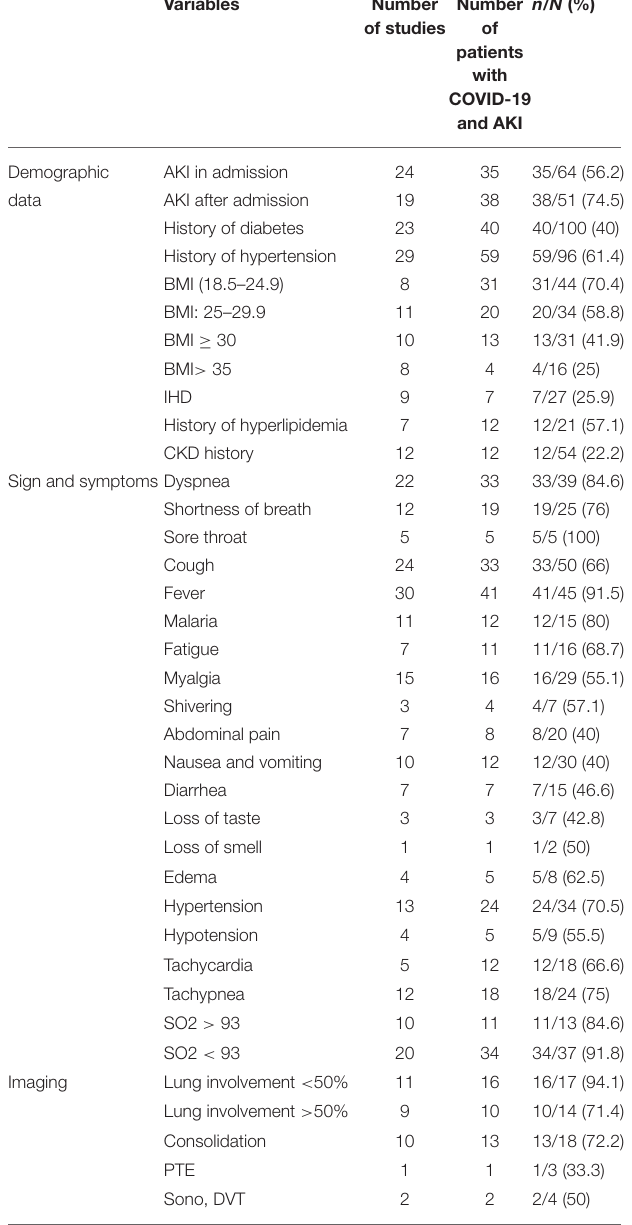
TABLE 3 | Summary of the case report and case series